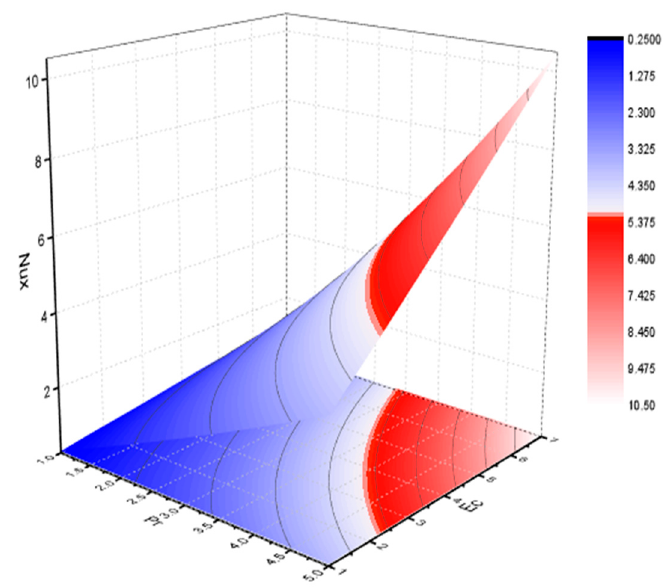
Figure 22. 3D visual of Cf x for β and M.